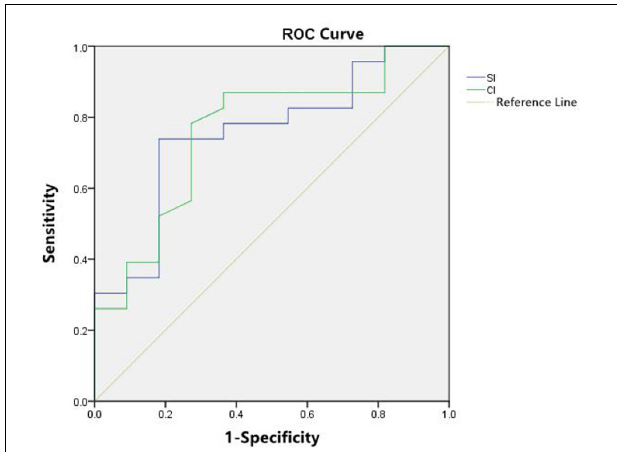
FIGURE 1 | Receiver operating characteristic (ROC) curve analysis showed good performance of stroke index (SI) and cardiac index (CI) as predictors of subsequent septic shock-related death and severe brain injury.